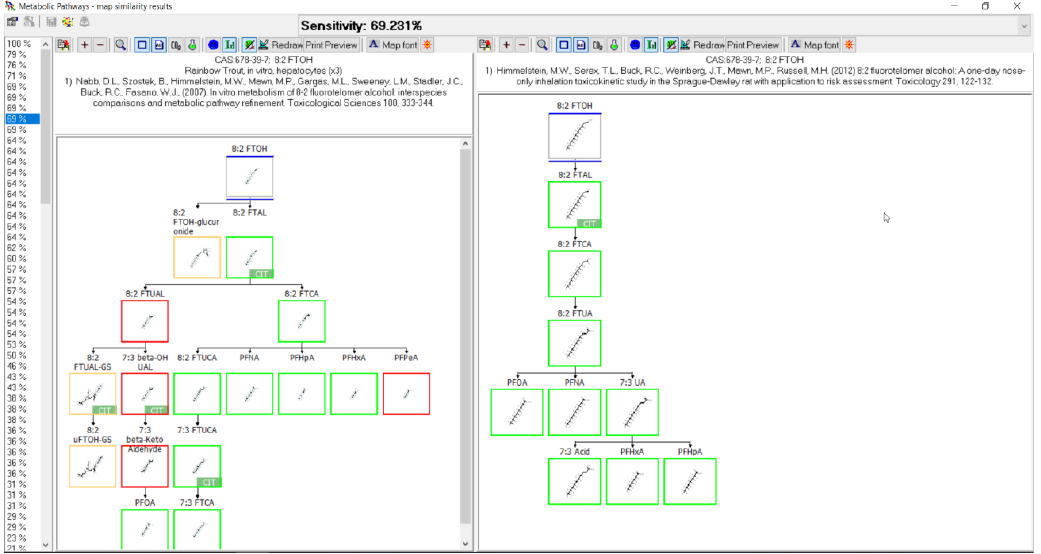
Figure 17. Metabolic map comparison of 8:2 FTOH in ( left ) rainbow trout hepatocytes and ( right ) in vivo rat. Metabolites common to both species are indicated by green boxes. Differences in metabolites are indicated by red boxes. Tan boxes indicate phase II conjugates. Sensitivity, in this case 69.231%, is an assessment of the map comparison whereby the number of common metabolites is divided by the total number of metabolites in the fish map. Metabolites labeled with CIT are presumed intermediates in the path but were not identified in the study.